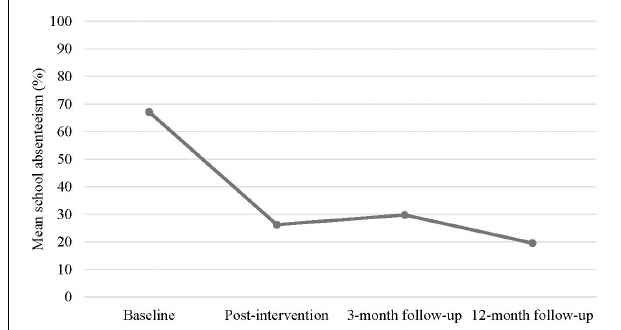
FIGURE 2 | Mean school absenteeism from baseline to 12-month follow-up.